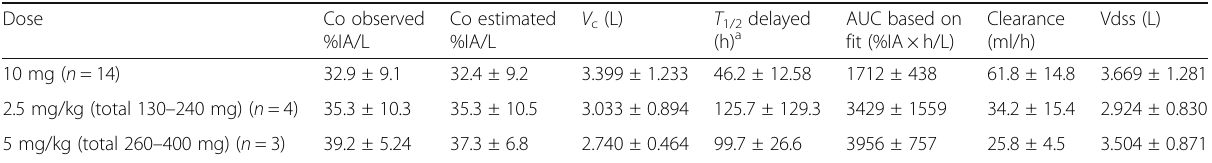
Table 2 I-124 codrituzumab pharmacokinetics Dose Co observed